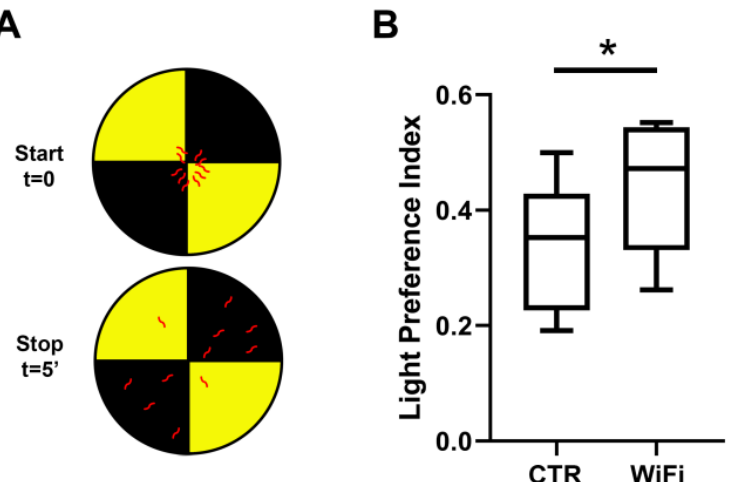
Figure 8. ( A ) Light preference test, example of a dish right after setting larvae on the test plate (Start) and after 5 min (End). ( B ) Percentage of larvae that preferred light were counted for each trial and all trials were averaged. The experiments were carried out in five independent biological replicates and 100 larvae were analyzed for each experimental group. Statistical significance was determined using the Paired t test (* p ≤ 0.05).